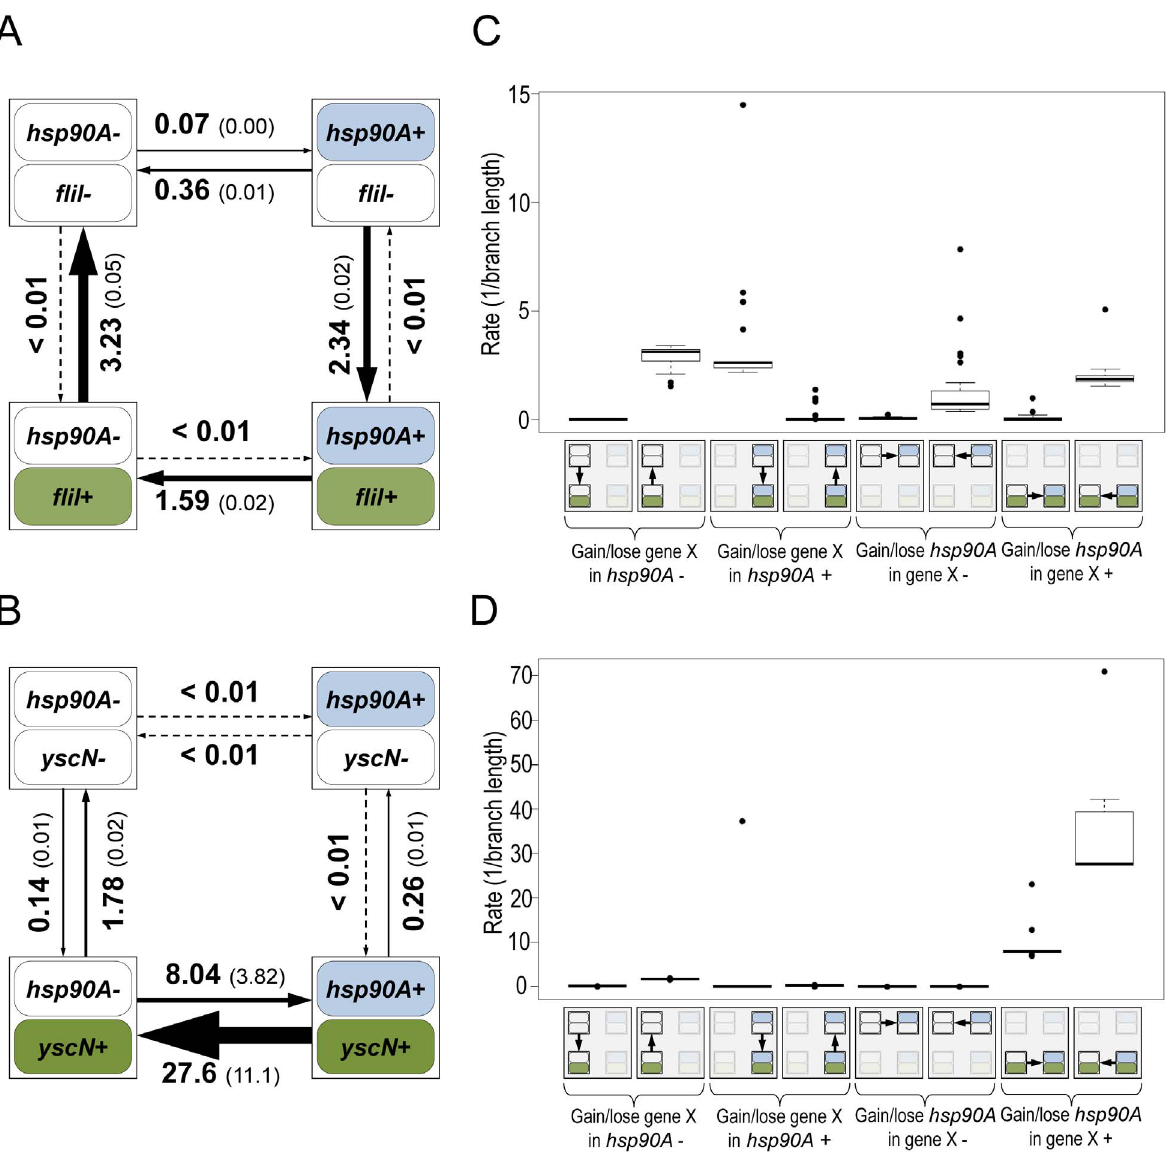
Figure 2. Flagellar genes and secretion system genes show distinct signatures of co-evolution with hsp90A . Schematic diagrams of the models describing the co-evolution of hsp90A with the flagellar gene fliI (A) and the non-flagellar Type III secretion gene yscN (B). The four boxes represent the four possible states of presence and absence in each model, and arrows represent transitions between them (gain or loss events). Arrow widths in each diagram are scaled to represent the rate of each transition. The average transition rate and standard deviation across multiple BayesTraits runs are displayed (see Methods). Box plots of the rates of gain and loss of all hsp90A -associated flagellar genes (n=27; C ) and all hsp90A - associated Type III secretion genes (n=10; D ) further demonstrate consistent co-evolutionary dynamics of genes in these categories. A box plot of all hsp90A -associated secretion genes (including all types) is provided as Figure S4.